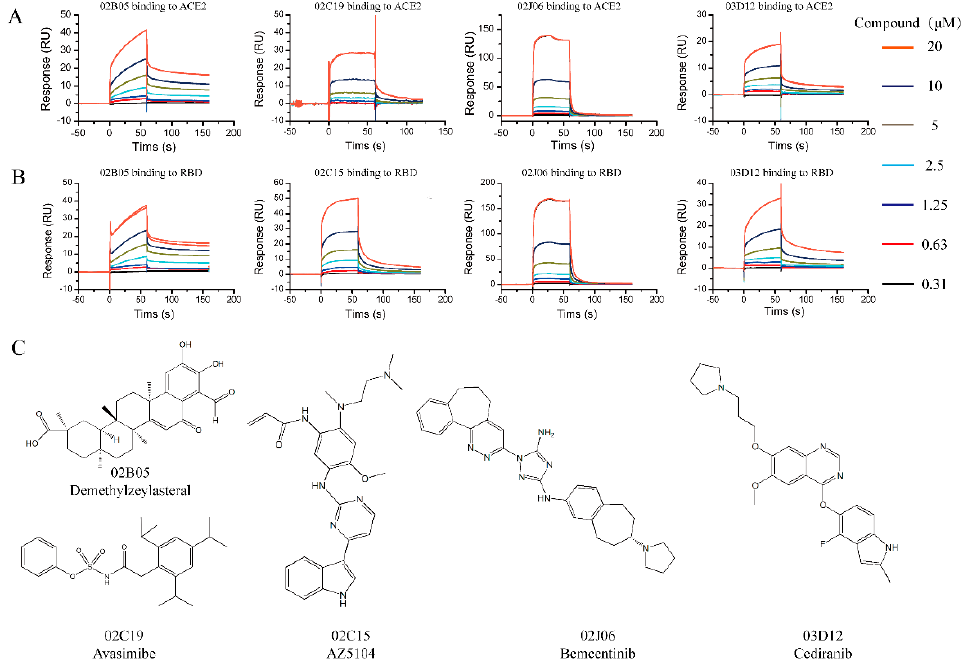
Figure 3. The sensorgrams and structures of compounds identified from the affinity screening. ( A ) Sensorgrams of compounds identified from the affinity screening bound to ACE2; ( B ) sensorgrams of compounds identified from the affinity screening bound to S-RBD. Increasing concentration of compounds were injected over the chip surface. The contact time was 60 s and dissociation time was 120 s. ( C ) Chemical structures of compounds discovered during SPR affinity screening.